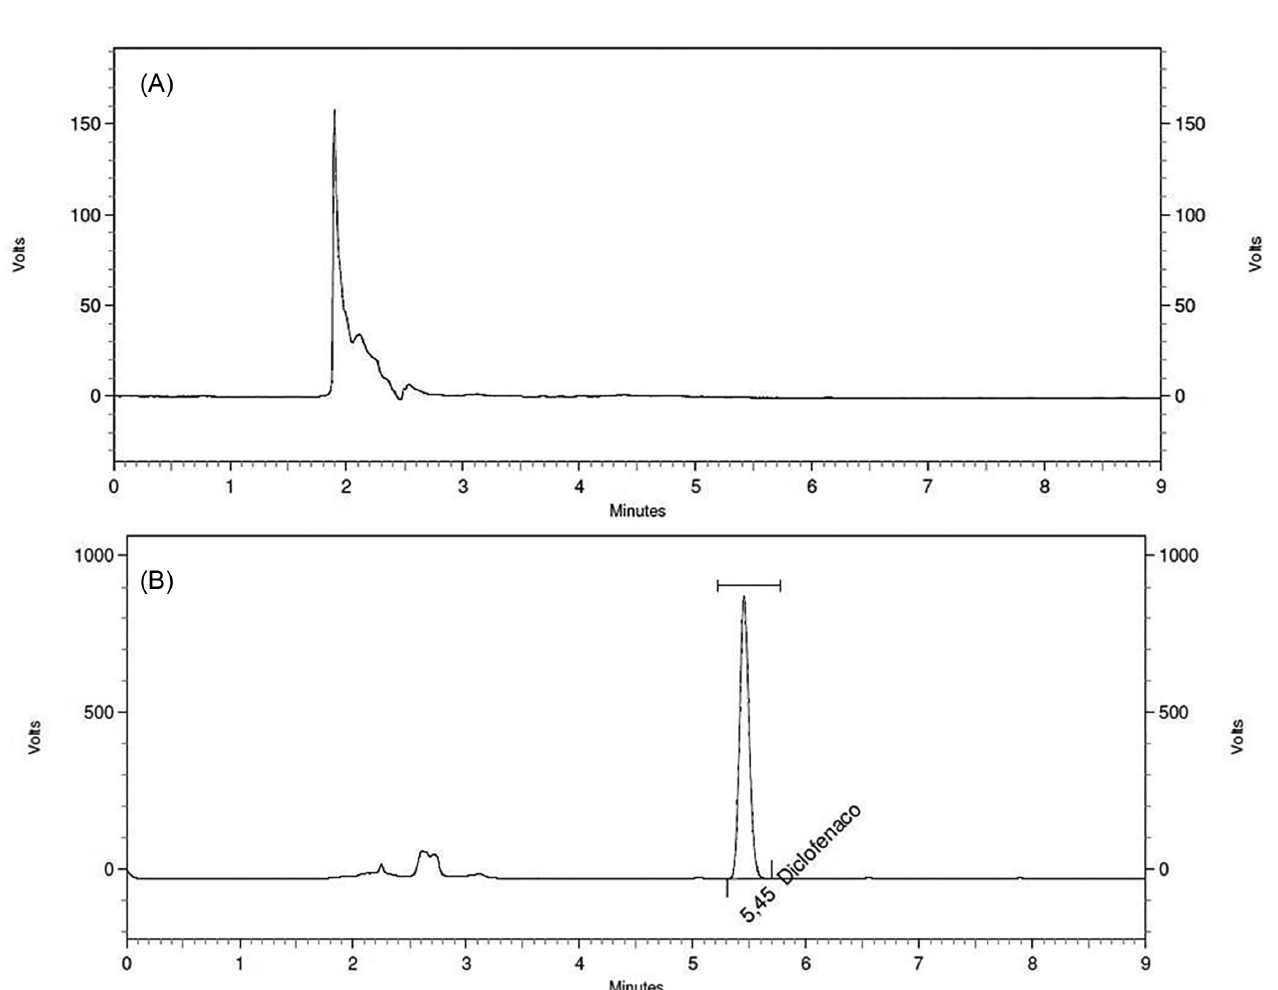
FIGURE 5 - Chromatogram analysis obtained from samples without diclofenac sodium addition (A) and samples with diclofenac sodium (B). Chromatographic conditions: chromatographic column ACE® C18 (25 cm x 4.6 mm, 5 μm particle size), mobile phase containing 30% phosphate buffer (pH 2,5) and 70% acetonitrile, 1.0 mL.min -1 flow, 254 nm detection, 25 μL injected volume and analysis time 9 TABLE II - Results obtained from diclofenac sodium solution analysis to build an analytical curve Concentration (mg.mL -1 )